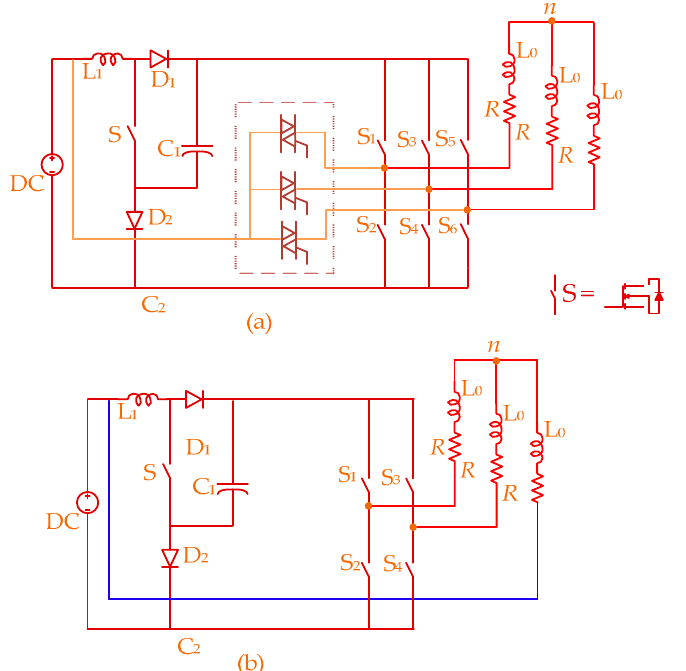
Figure 14. Fault-tolerant three-phase quasi-switched boost inverter. ( a ) Normal operation; ( b ) Reconfigured circuit.